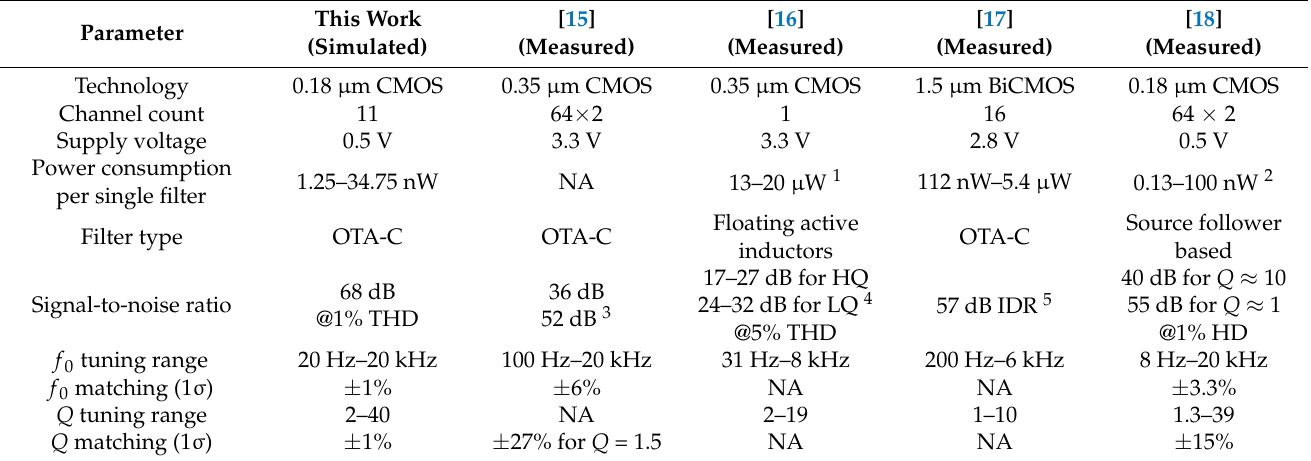
Table 2. Performance comparison of filter banks designed for electronic